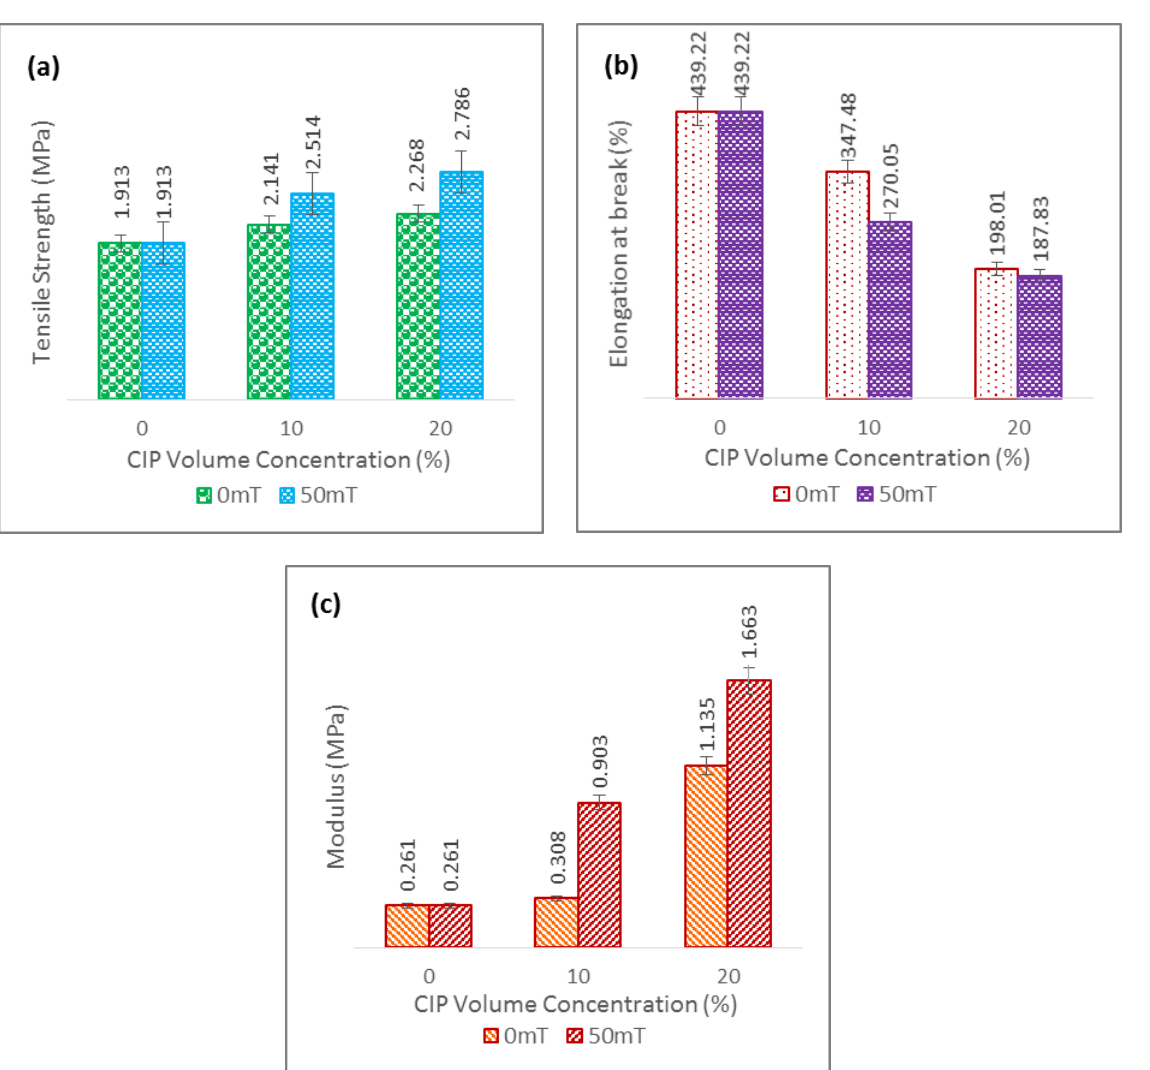
Figure 4. Graphs of ( a ) tensile strength, ( b ) elongation at break, and ( c ) engineering modulus of pure SR and anisotropic silicone-based MREs with 10 and 20 vol.% CIPs during off-state (0 mT) and on-state (50 mT) conditions.